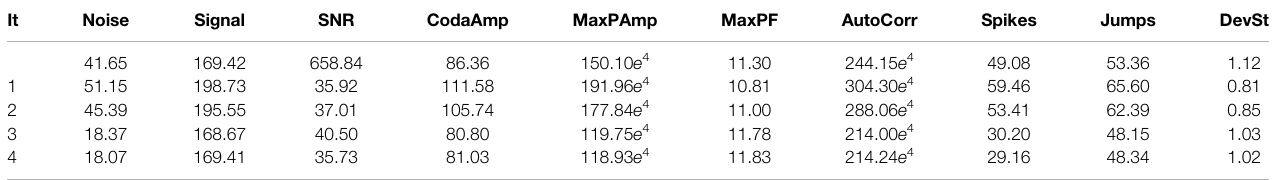
Comparison between values of alternative parameters considered in data selection for the four